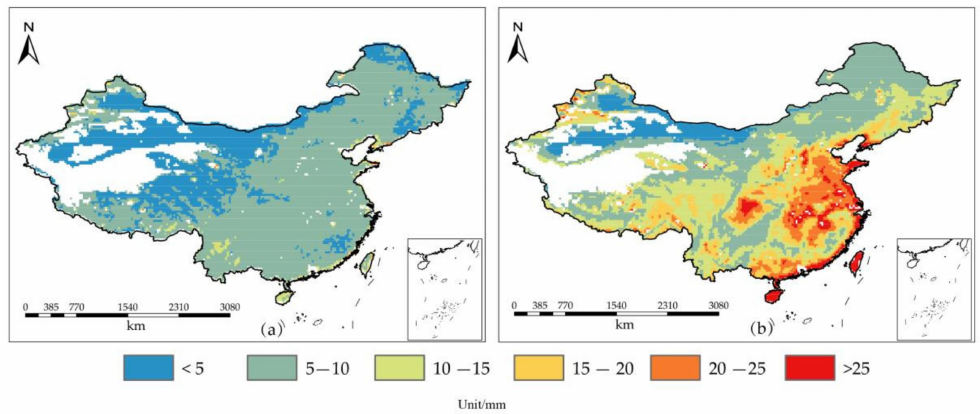
Figure 3. The spatial MAE distribution of the DL and MME methods in the test dataset, ( a ) DL merged data, ( b ) MME merged